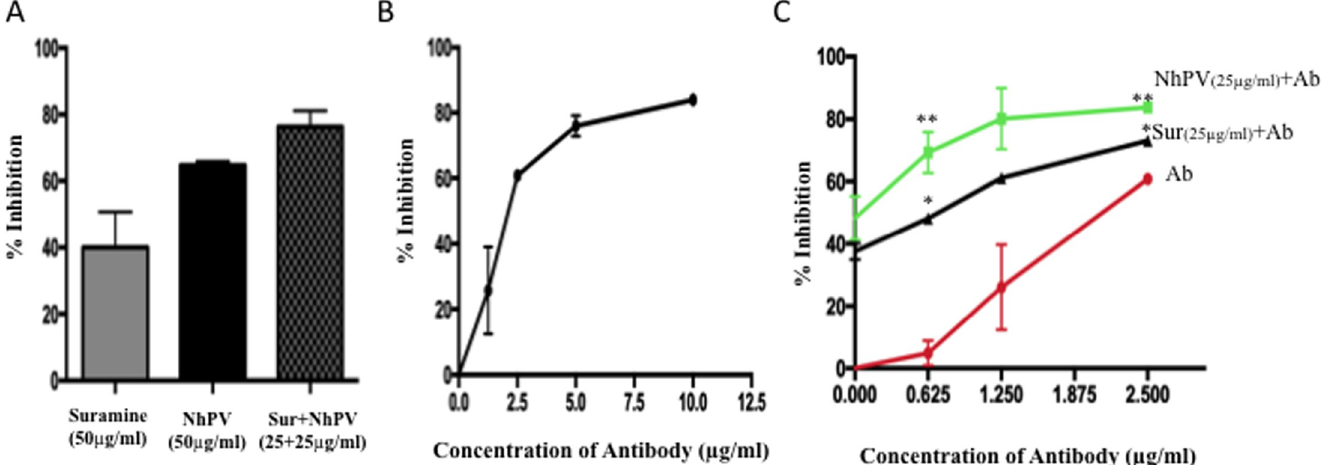
Fig 5. Enhanced inhibitory effects mediated by combination of NhPV and Suramin with neutralizing antibody (SAD-S35). A) 293T ACE2 cells were infected with SP Δ C G614 -PVs in presence of NhPV (50 μ g/ml) or suramin (50 μ g/ml) alone or a mix of NhPV and suramin (each with 25 μ g/ml). The Gluc activity in the supernatant was measured after 48 hrs and present as % inhibition. B) Inhibitory effect of nAb SAD-S35 on SP Δ C G614 -PVs infection. 293T ACE2 cells were infected with SP Δ C G614 - PVs in the presence of serially diluted SAD-S35 (1.25 to 10 μ g/ml) for 3 hrs. Then infected cells were cultured in fresh medium. At 48 hrs pi., the Gluc activities in the supernatants were measured and presented as % inhibition. C) 293T ACE2 cells were infected with SP Δ C G614 -PVs in the presence of serially diluted SAD-S35 (0.625 to 2.5 μ g/ml) alone or mixed with NhPV (25 μ g/mL) or Suramin (25 μ g/mL) for 3 hrs and the infected cells were cultured in fresh medium. At 48 hrs pi., the Gluc activities in the supernatants were measured and presented as % inhibition. The results are the mean ± S of duplicate samples, and the data are representative of results obtained in two independent experiments. Statistical significance was determined using unpaired t-test between NhPV+Ab/Ab or Suramin +Ab/Ab, and significant p values are represented with asterisks, � � 0.05, �� � 0.01.